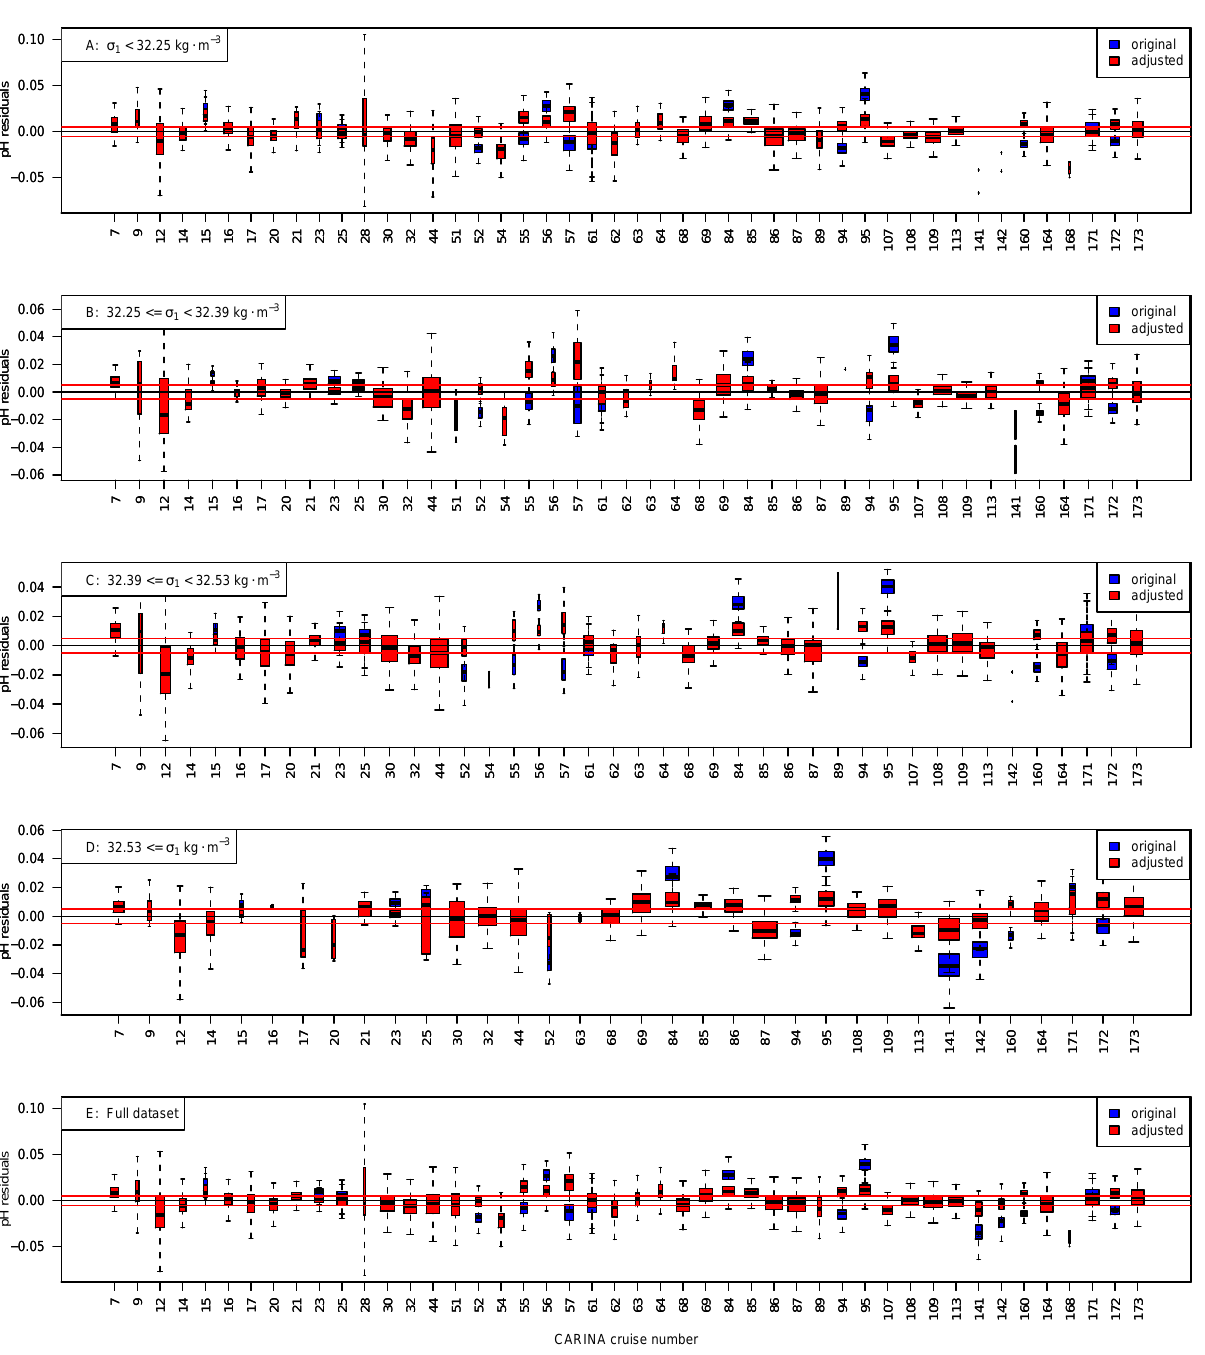
Figure 27. pH residuals obtained from the CARINA dataset by applying an MLR for pH data against Theta, Salinity, Latitude, AOU, Nitrate, Phosphate and Silicate. (A) to (D) are CARINA subsets for the indicated σ 1 intervals, and (E) is the combined residual for the full dataset. Blue values are residuals with the original unadjusted pH values, and red values are the final adjusted pH values. Red lines are the ± 0.005 pH units used as lower limit for adjustments in the secondary